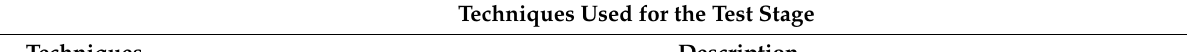
Figure 7. Play activities of the application.